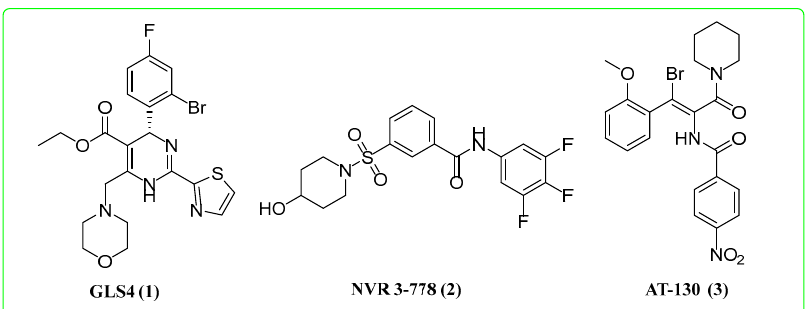
Figure 1. The structures of some representative HBV CpAMs.